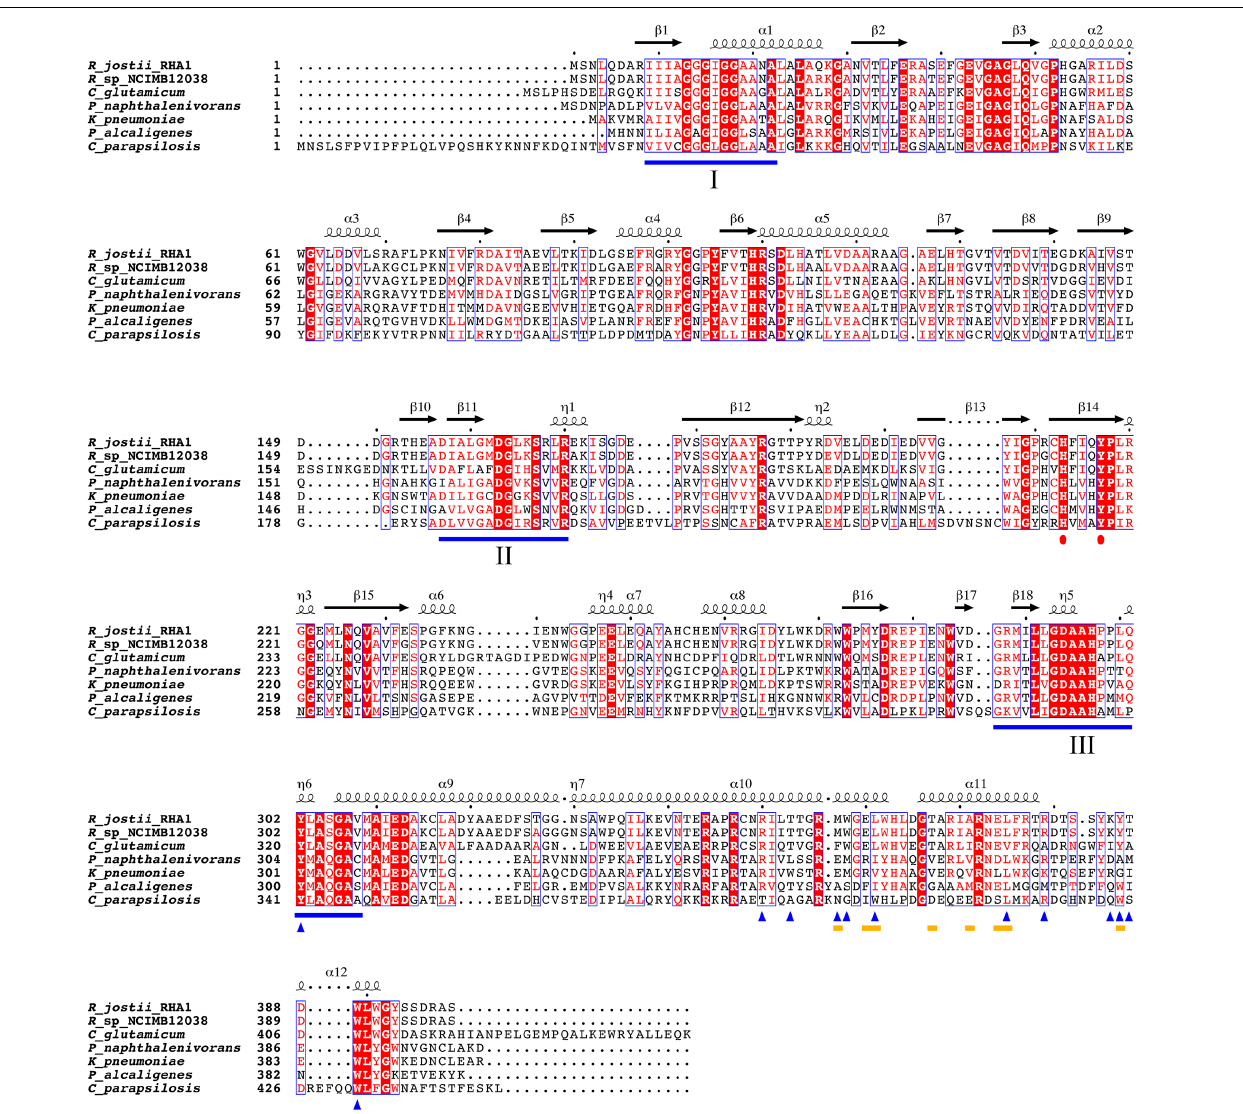
FIGURE 5 | Multiple sequence alignment of known 3HB6H enzymes. UniProt ID numbers: Q0SFK6, R. jostii RHA1; E7CYP8, Rhodococcus sp. NCIMB 12038; Q8NLB6, C. glutamicum ATCC 12032; Q3S4B7, P. naphthalenivorans CJ2; Q6EXK1, K. pneumonia M5a1; Q9F131, P. alcaligenes NCIMB 9867; CPAG_03410, C. parapsilosis . Identical residues are shown in red. Flavin binding motifs are underlined in blue [ I : GXGXXG; II : DG; III : GD (Eppink et al., 1997)]. The His-Tyr pair involved in substrate binding and hydroxylation is marked with red dots. The yellow lines mark residues involved in dimerization contacts. Blue triangles indicate residues involved in lipid binding. Secondary structure assigned from the 3HB6H crystal structure (4BK1). Diagram was produced using ESPript (Robert and Gouet,